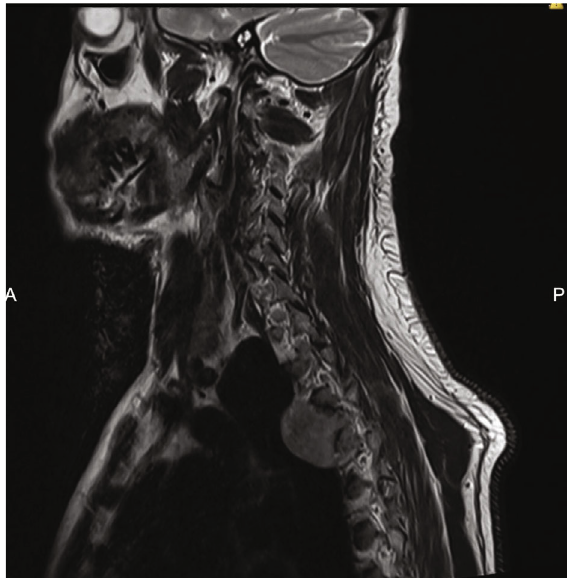
Figure 2: T2-weighted sagittal (view/section) MRI of the neck showing the pleural lesion.